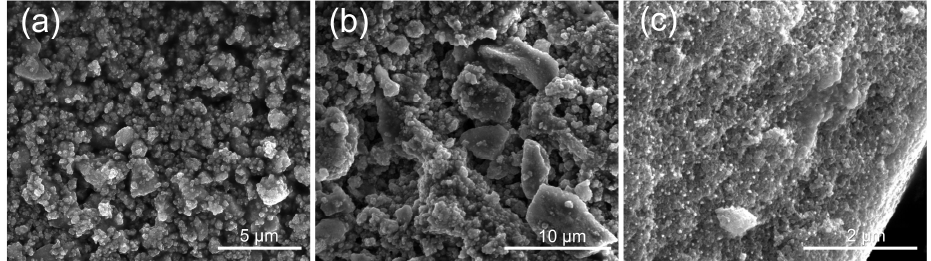
Figure 2. Scanning Electron Microscopy (SEM) images of ( a ) TiO 2 NPs, ( b ) TiO 2 /SiO 2 , and ( c ) TiO 2 /Ag.